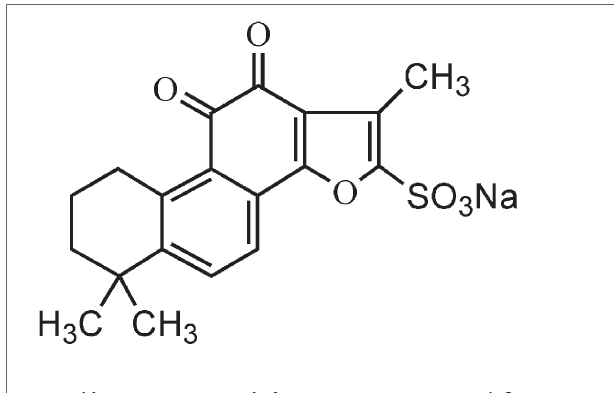
FIGURE 3 | Chemical structures of sodium tanshinone IIA sulfonate.